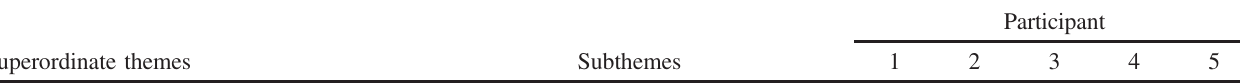
TABLE II. Superordinate and subthemes and their representation across participants, organized by research